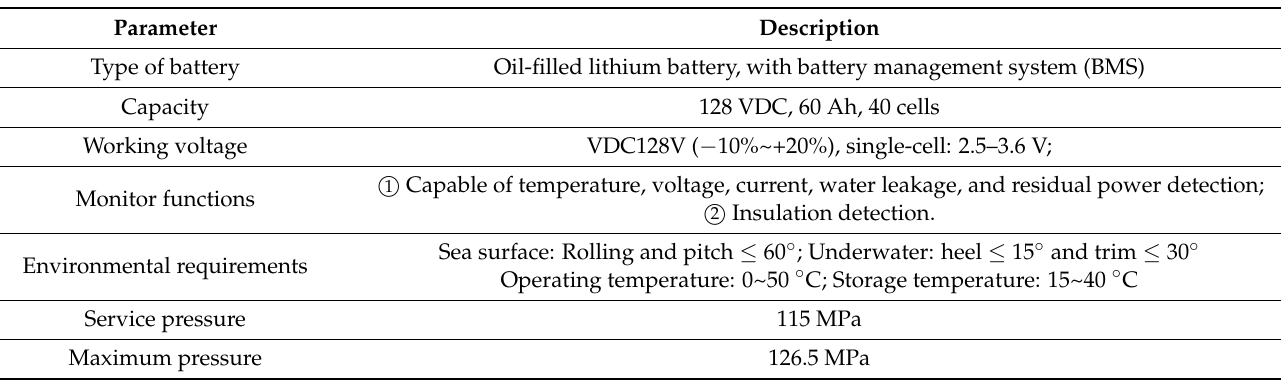
Table 8. The battery specifications.